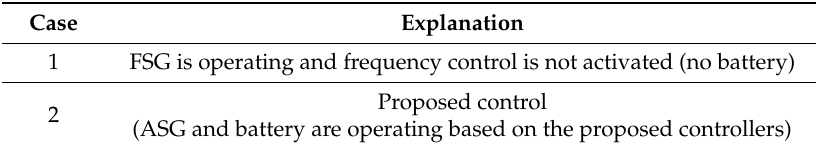
Table 2. Simulation cases.